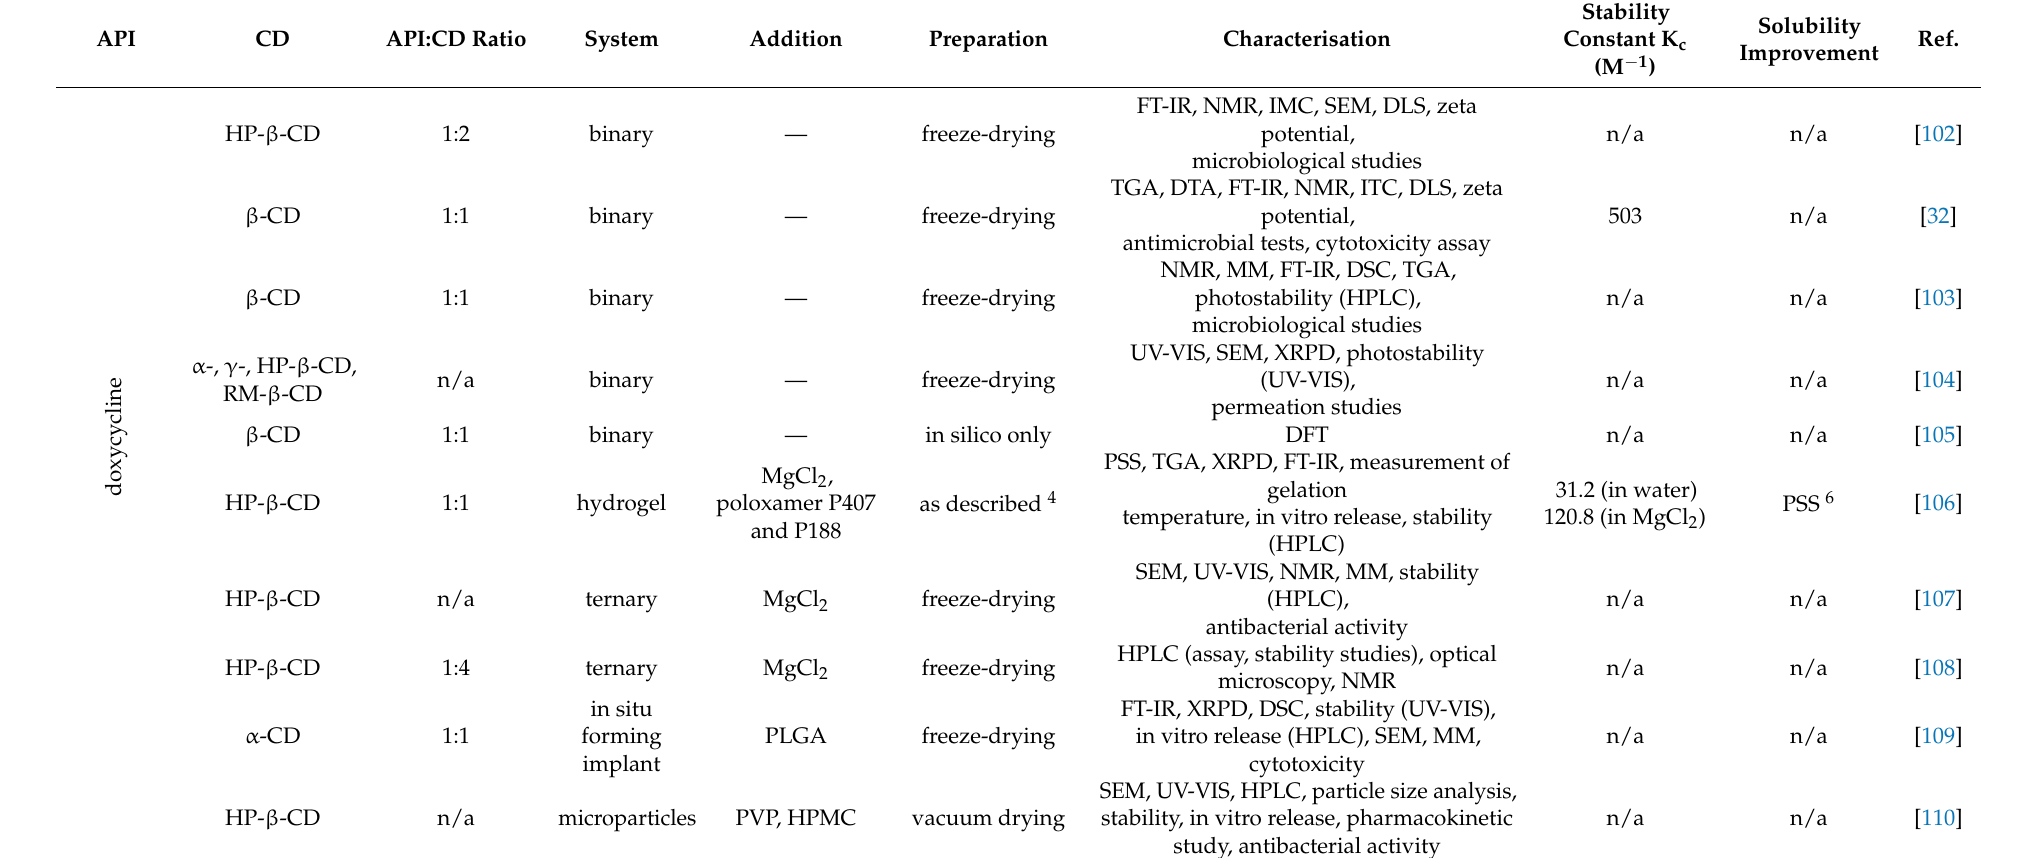
Table 4. Detailed information of tetracycline complexes on the types of CDs used, methods of complex preparation, and techniques used to characterise the obtained products